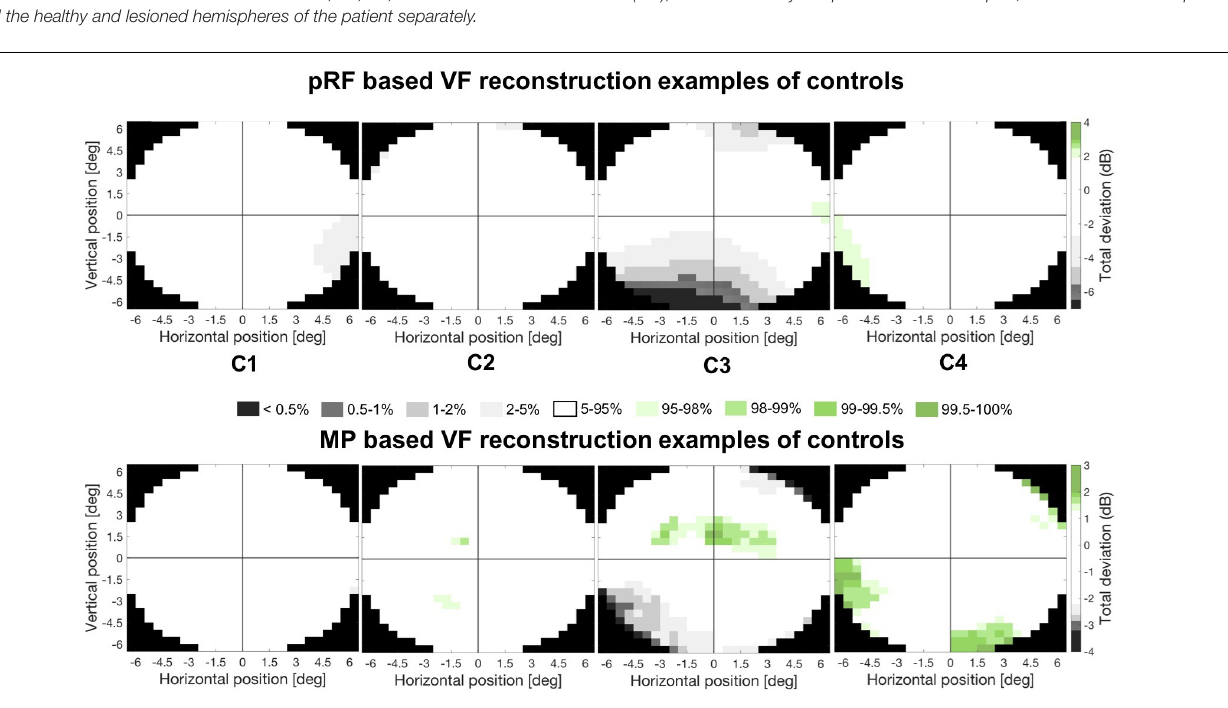
FIGURE 6 | Example VF reconstructions. VF reconstructions for both the pRF mapping (upper panel) and MP technique (lower panel) for 4 control participants. In these plots, white pRF or MP-based coverage indicate VF sensitivity to be within normal limits (90% CI), the gray and green patches indicate a VF sensitivity below (lower 5%) or above (upper 5%) normal limits, respectively. Only the central 6.5 ◦ were reconstructed, reflecting the region of the VF stimulated during the VF